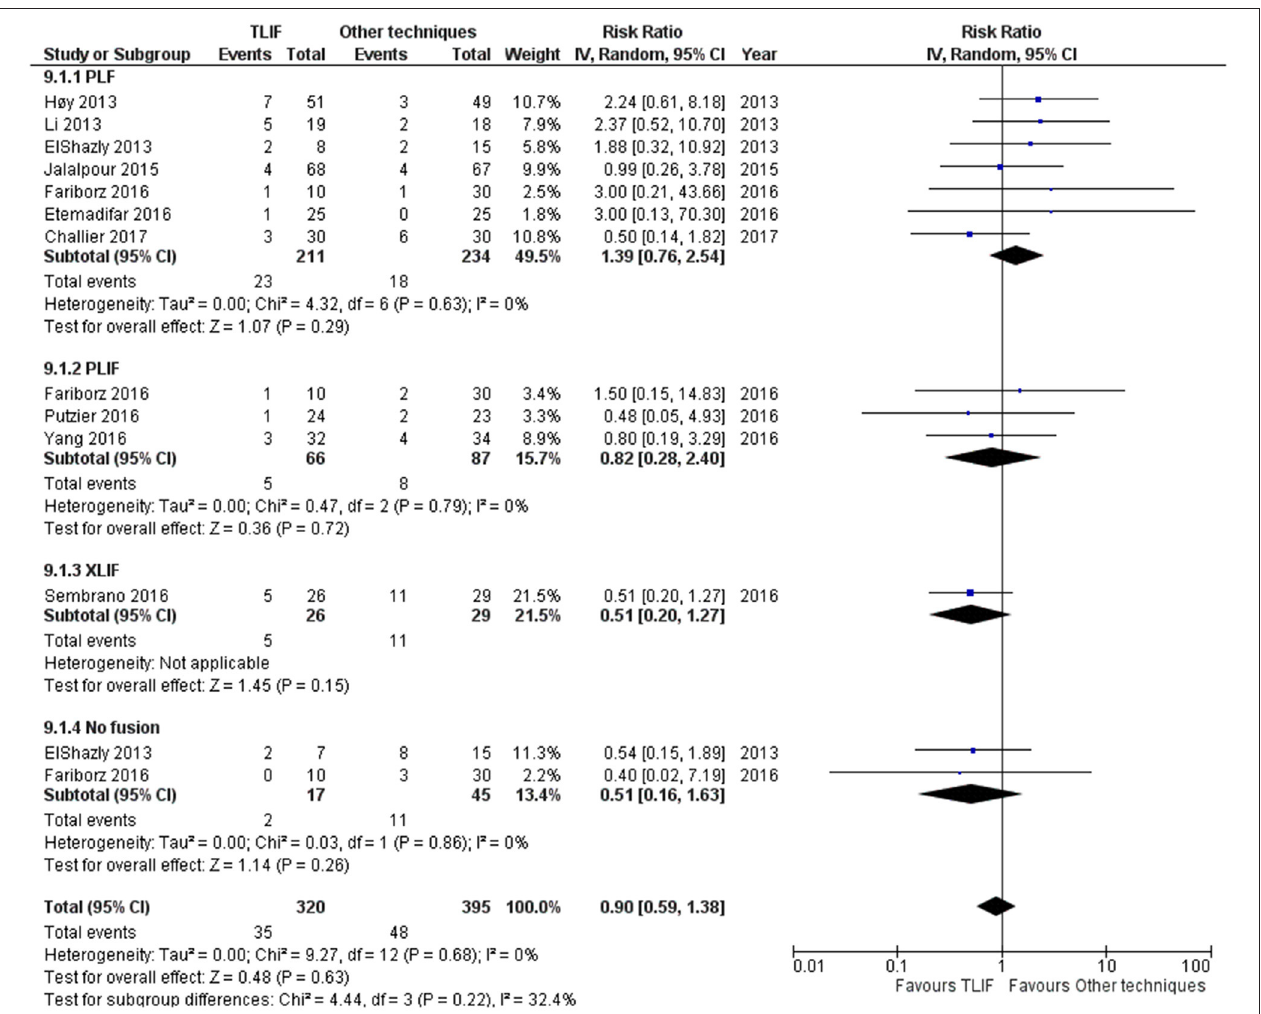
FIGURE 4 | Forest plot and tabulated data illustrated the RR for adverse events between TLIF, PLF, PLIF, XLIF, and no fusion showing that there was no significant difference in adverse events between procedures. CI, confidence interval; df, degrees of freedom.